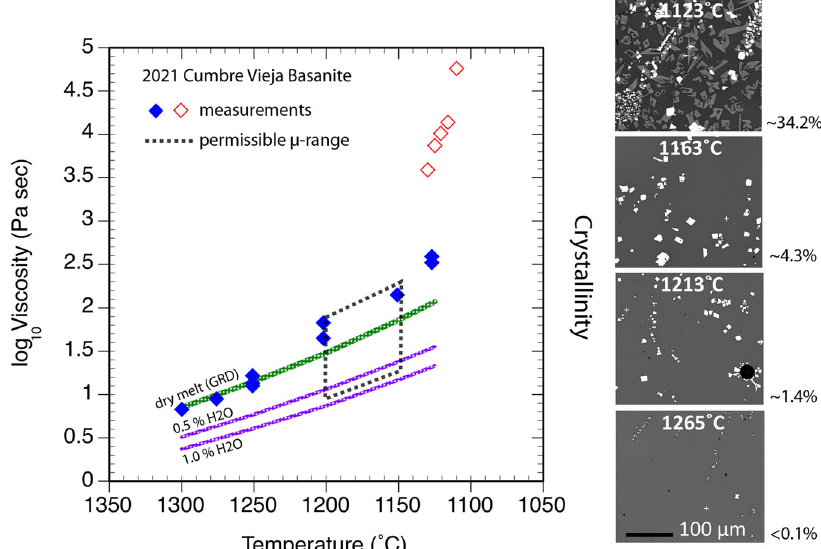
Fig. 6 The viscosity of the 2021 Cumbre Vieja basanite. Results of rheological measurements (log 10 µ ) performed at 1-atm and temperatures from 1300 to 1110°C. Owing to the 1-atm conditions of these stirring experiments, the melts became thoroughly degassed and thus, the data (blue diamonds) represent nominally anhydrous viscosities. All viscosities are effective values as the melt contained crystals throughout the experiments; BSE images on the right demonstrate crystal contents (determined from BSE image analysis) as a function of temperature in separate 1-atm heating experiments. The smooth shift towards higher viscosities with falling temperature interval from 1300 to 1125°C (blue diamonds) demarcates viscosities of low-crystallinity melts. A step- function change to higher viscosities occurs at T <1125°C (open red diamonds) and highlights the in fl uence of high crystal contents (e.g., as shown in the top right BSE image). Predicted basanite viscosities derived from the GRD viscosity model 7 are indicated by the green and two purple curves, the latter of which track hydrous melt viscosities for a basanite melt containing 0.5 and 1.0 wt.% H 2 O. As the 2021 basanite may have contained up to 0.8 wt.% H 2 O, its minimum viscosities will plot between the purple hydrous GRD curves within the permissible eruption temperature range of 1150 – 1200°C. In total, Cumbre Vieja ’ s effective eruptive viscosity range can be bracketed by the area enclosed by the bold dashed line; this range accounts for all the likely parameters including T , composition, crystallinity and hydrous components in the